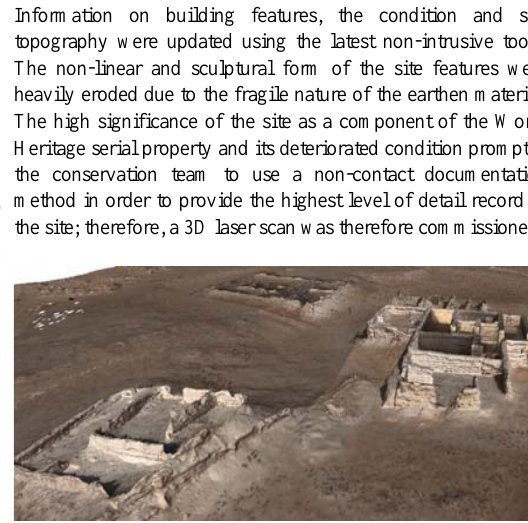
Figure 7. A snap shot of 3D model shows all three houses of Hili 17.